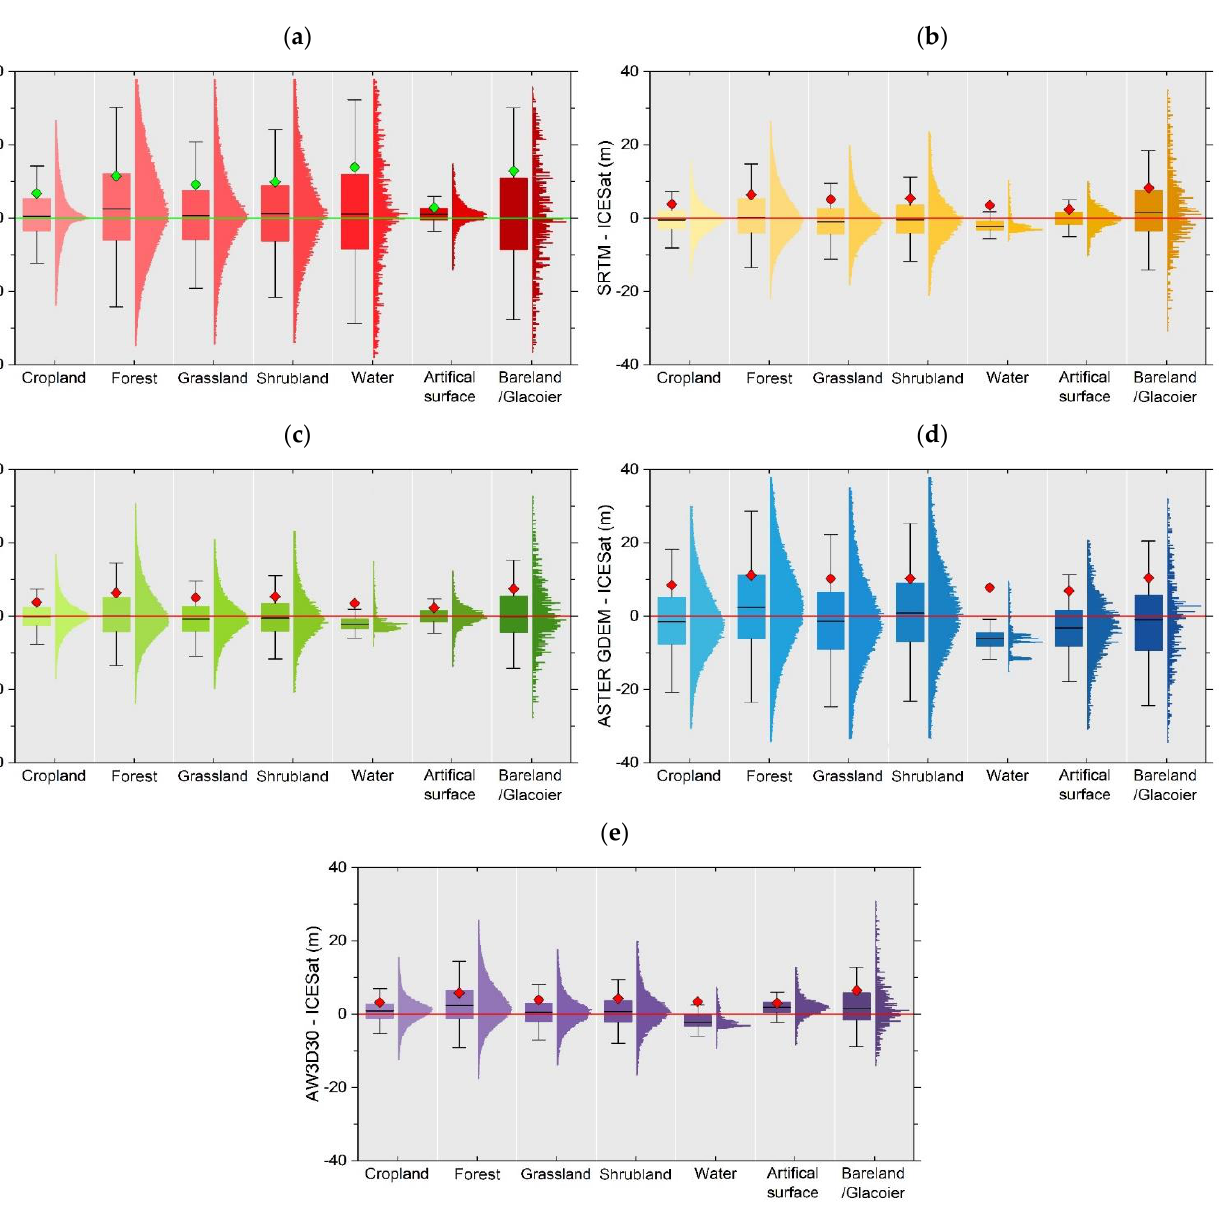
Figure 9. The differences (i.e., bias) between five DEM products and ICESat/GLAS GCP points, shown boxplots and distribution histograms according to different landcover types: ( a ) Tan-DEM-X90, ( b ) SRTM, ( c ) NASA, ( d ) ASTER GDEM, and ( e ) AW3D30.